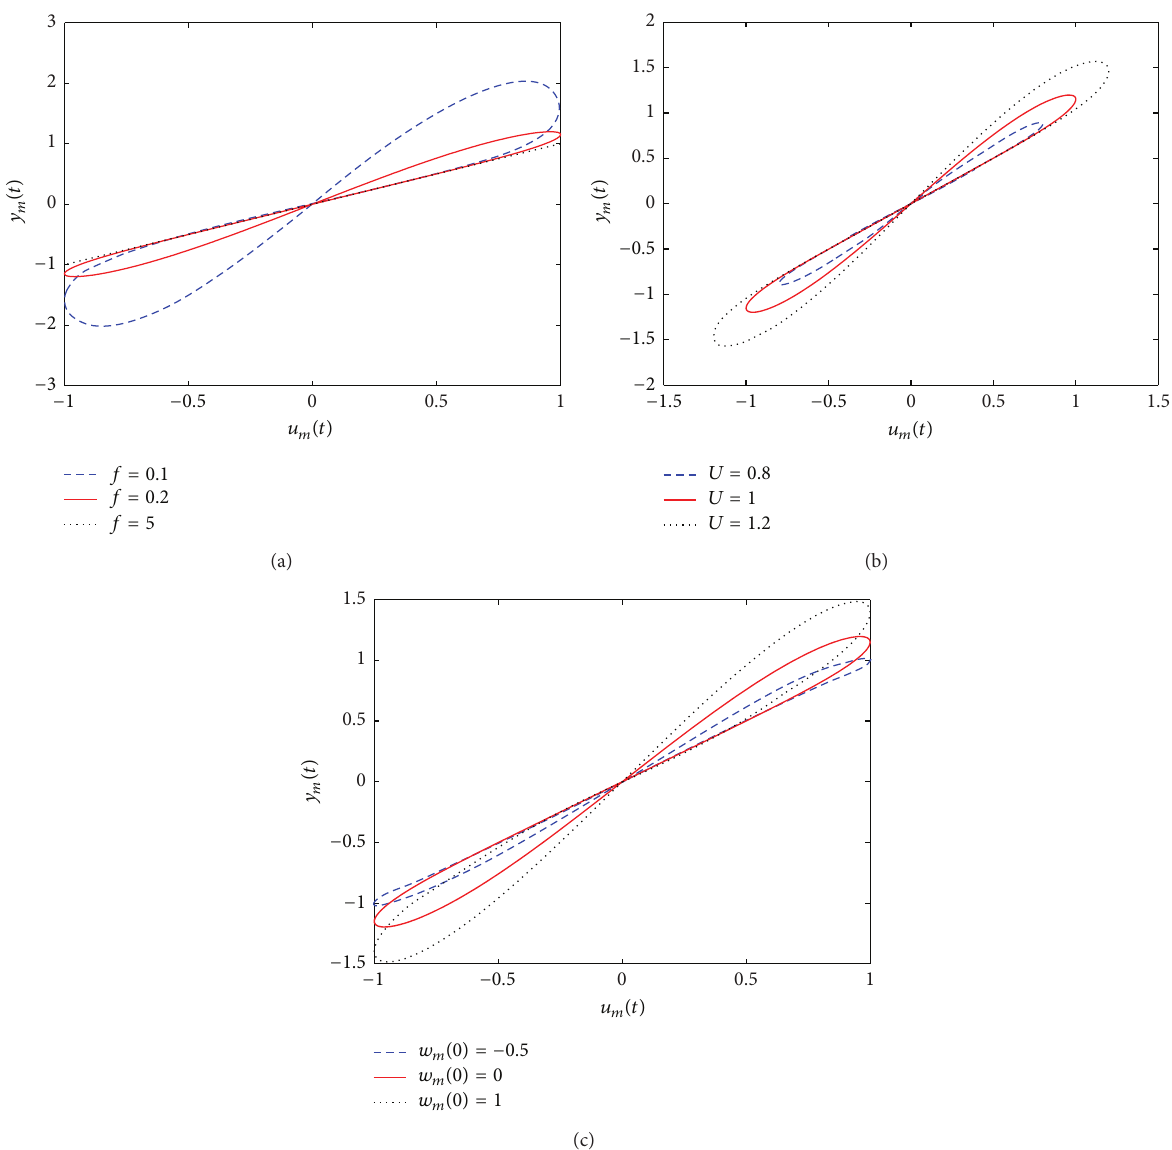
Figure 1: Hysteresis loops of the proposed memristive device (2) driven by a sinusoidal stimulus (3) when (a) 𝑈 = 1 , 𝑤 𝑚 (0) = 0 , and varying frequency 𝑓 , (b) 𝑓 = 0.2 , 𝑤 𝑚 (0) = 0 , and changing input amplitude 𝑈 , and (c) 𝑈 = 1 , 𝑓 = 0.2 , and using different initial states 𝑤 𝑚 (0)